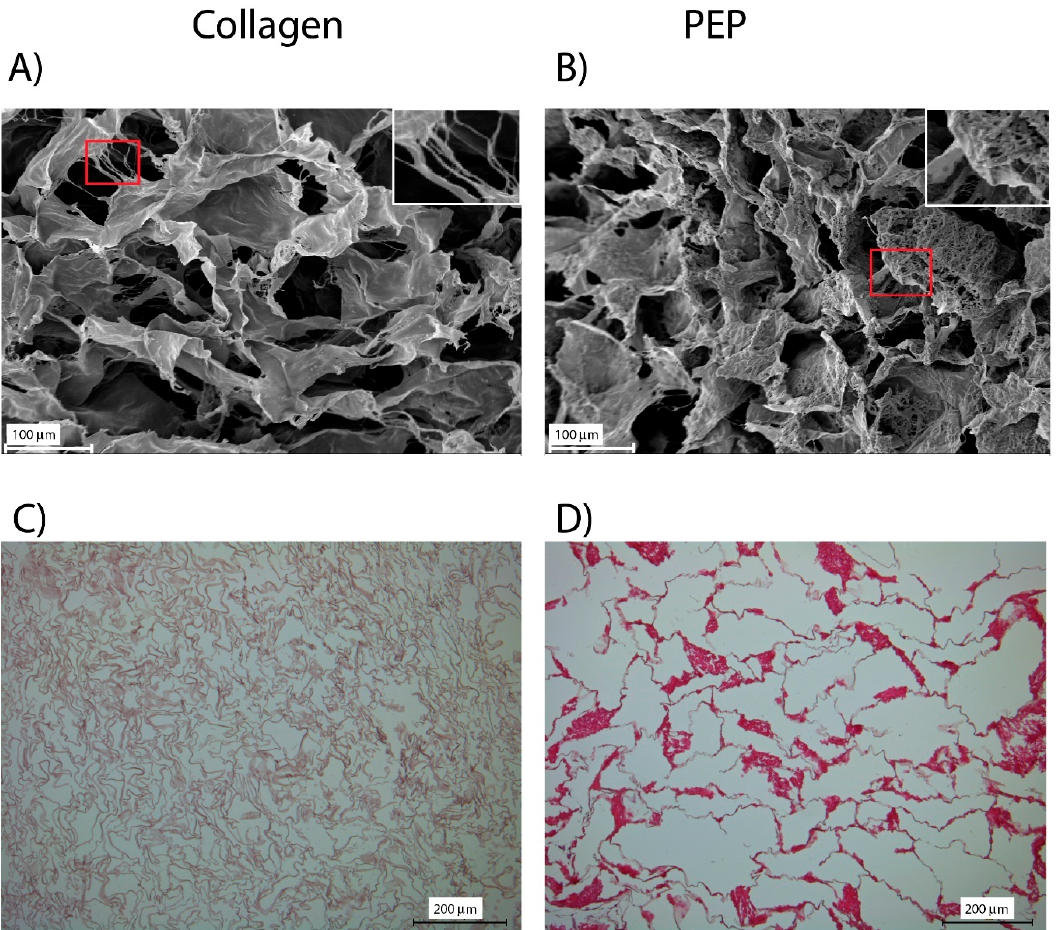
Figure 2. Characterization of scaffolds by SEM-analysis ( A , B ) and light microscopy with hematoxylin and eosin (HE)-staining ( C , D ). Scaffold consisting of collagen ( A ) visualized a porous structure with fibrils interconnected (larger magnification) between sheet-like structures. A similar porous structure was also obtained in scaffold-containing PEP ( B ), but with aggregates of PEP-structures (larger magnification) within. The fibril-like structures of PEP in a criss-cross pattern was more closely packed. HE-staining demonstrated an organized collagen pattern ( C , D ), and an even distribution of PEP-clusters of more a pinkish color ( D ).